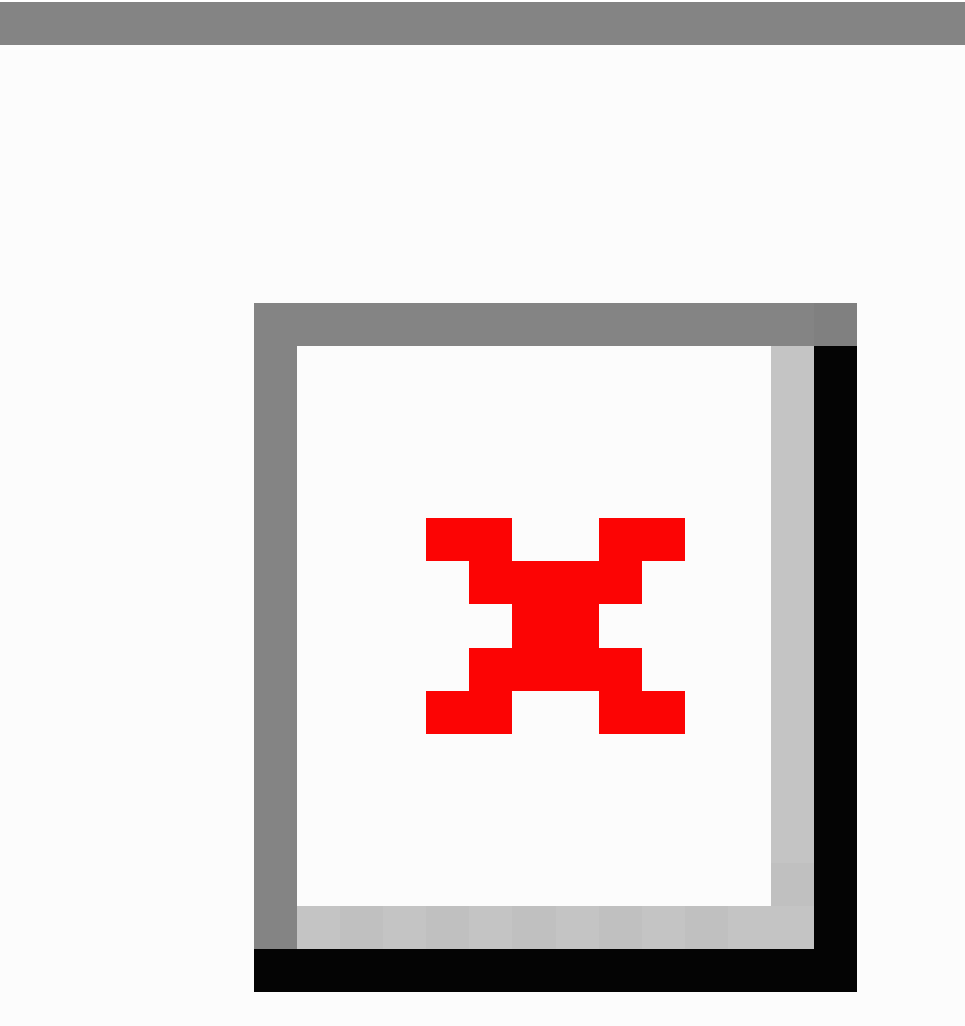
Figure 2. Differences in weights (self-reported – clinic) by the average of the two weights at 24